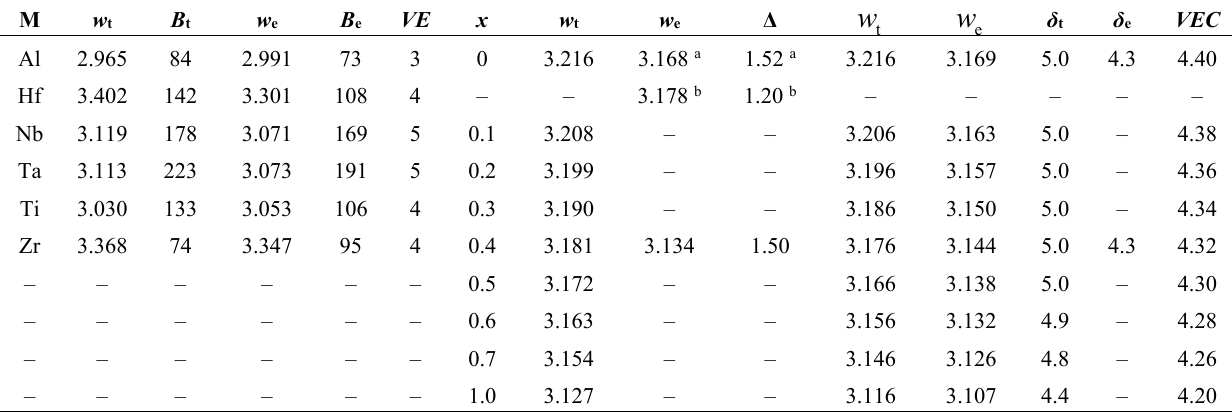
Table 1. WS radii ( w , units of Bohr) for the pure metals (M) in their equilibrium crystal structure and for Al x Hf 1 − x NbTaTiZr in the bcc structure shown as a function of Al content. w t and w e represent the theoretical (EMTO) and the experimental WS radius, respectively, B t is calculated bulk modulus, B e is the experimental one. VE stands for the number of valence electrons.